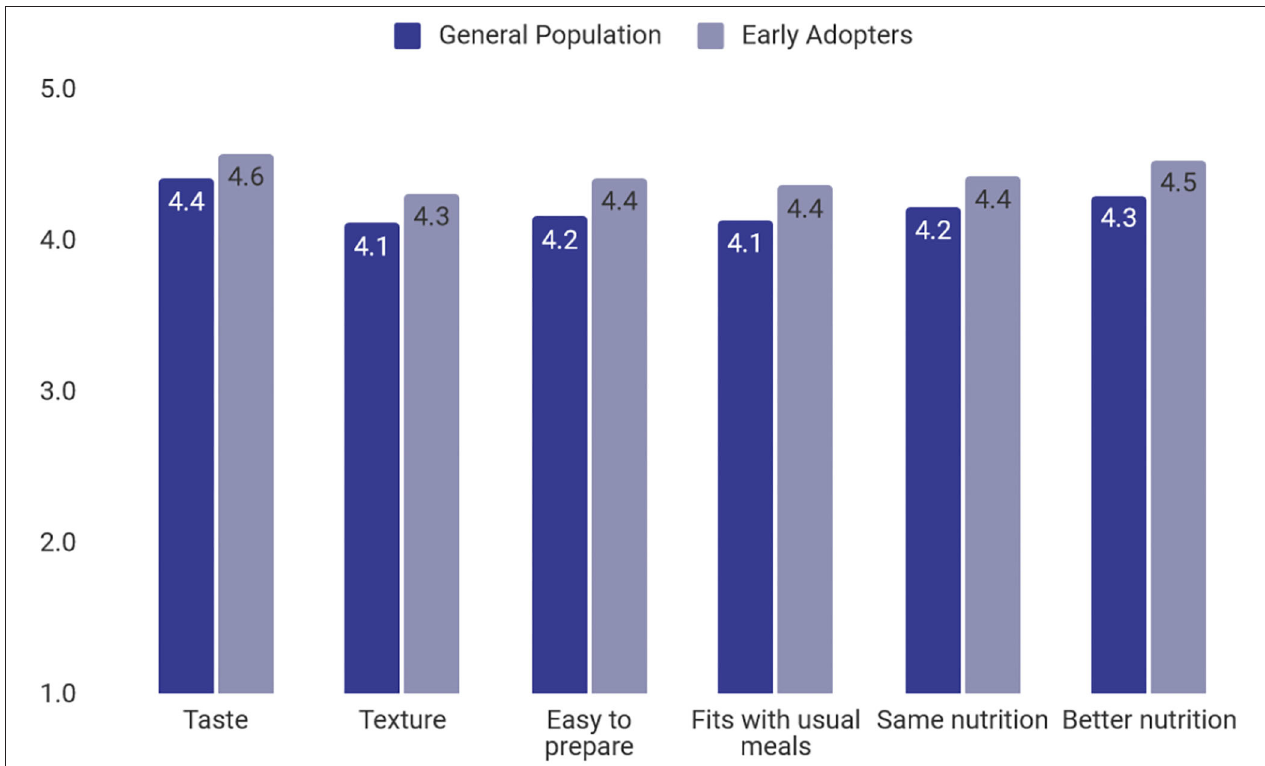
FIGURE 11 | Mean importance of characteristics of plant-based meat in the general population and among early